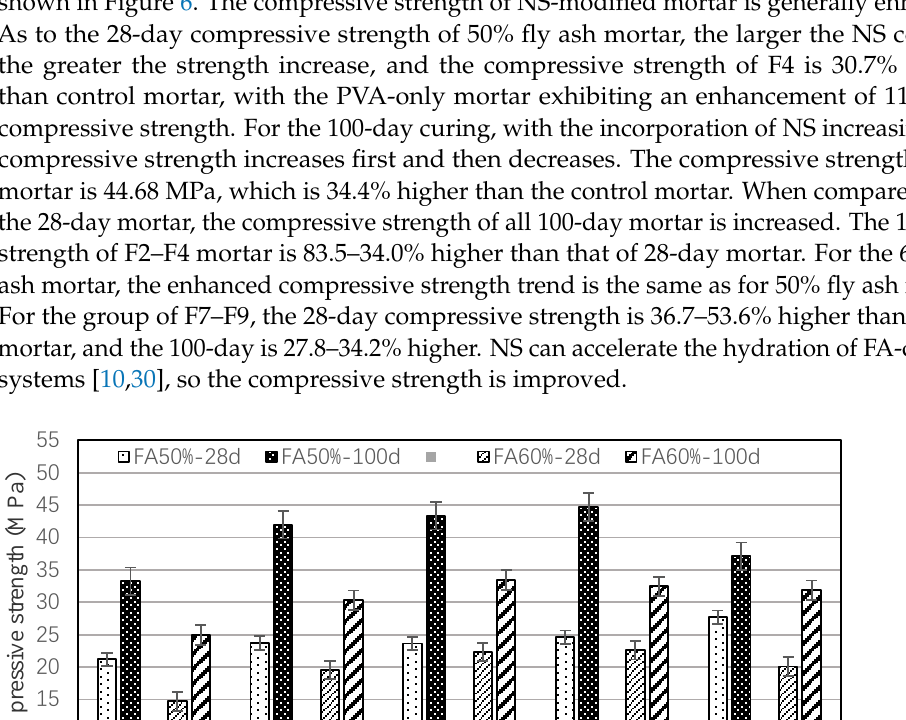
Figure 6. Compressive strength of NS-modified